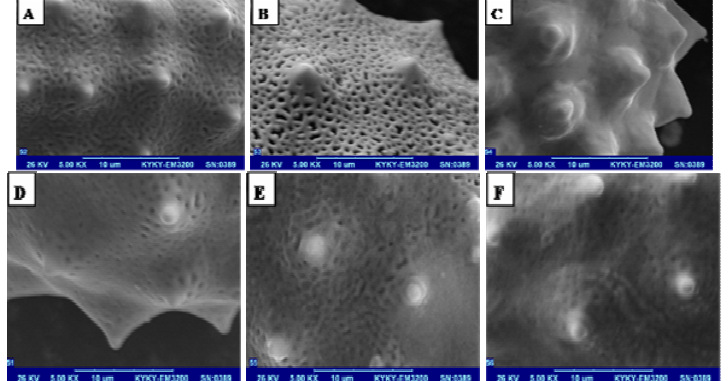
Fig.1: Dendrogram by Ward method for Onopordum species studied. 1: O. acanthium , 2: O. carduc horum, 3: O. armenum , 4: O. leptolepis , 5: O. heteracanthum , 6: O. carmanicum.